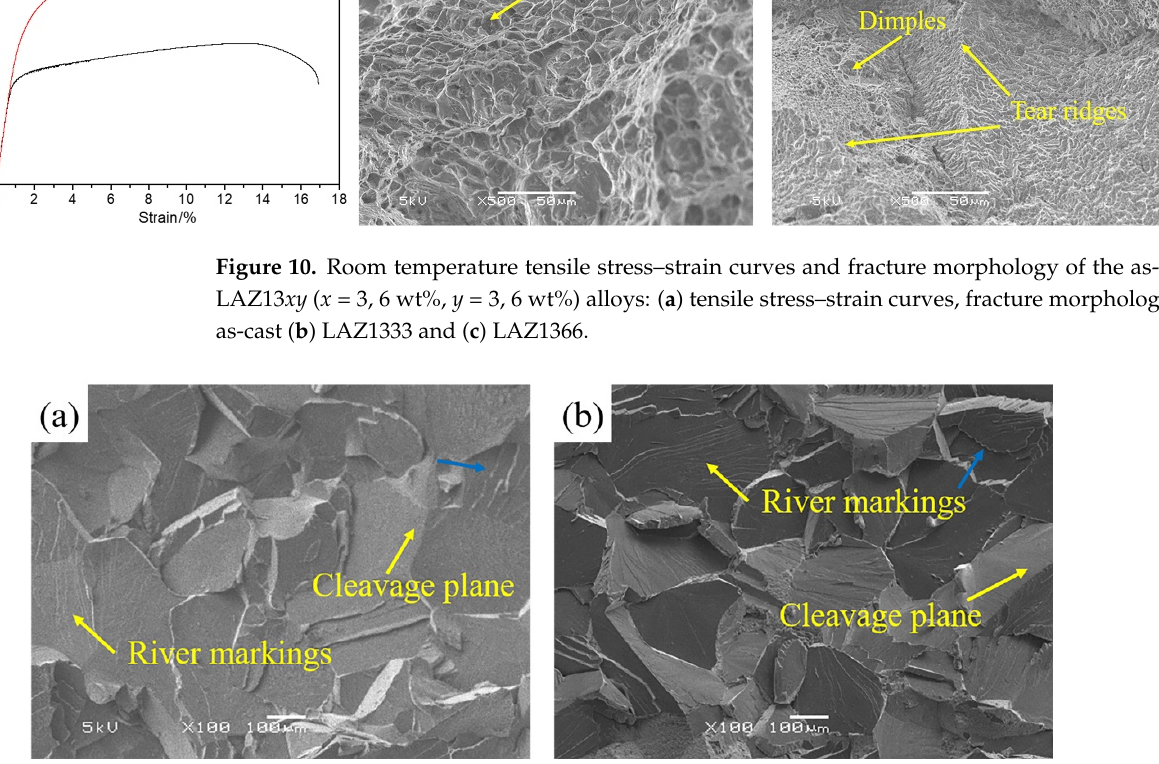
Figure 11. Tensile fracture morphology of the as-solutionized LAZ13 xy ( x = 3, 6 wt%, y = 3, 6 wt%) alloys: ( a ) LAZ1333, ( b ) LAZ1366.